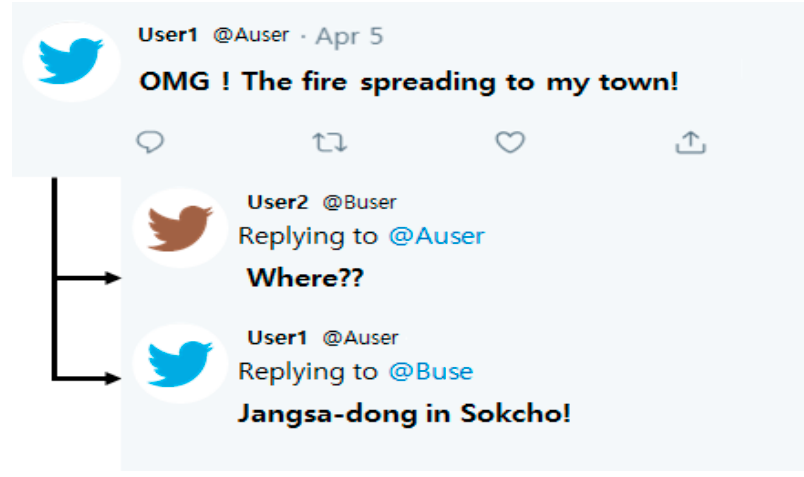
Figure 5. Example of relevant documents.